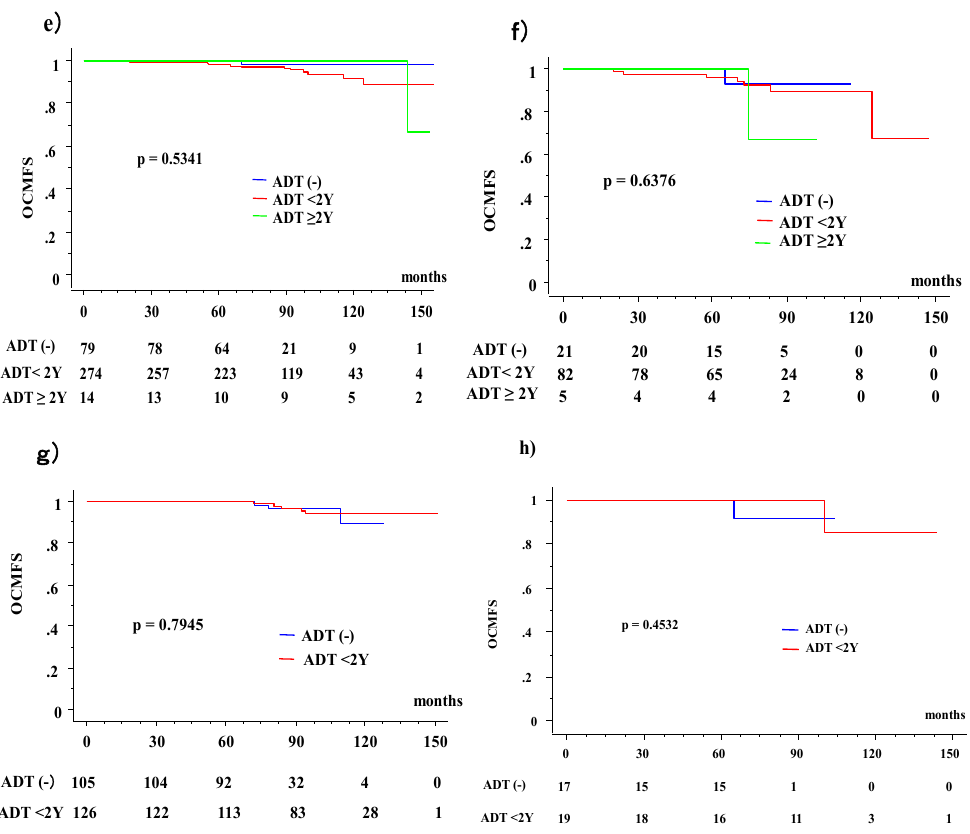
Table 6. Cause of other cause of mortality (OCM).